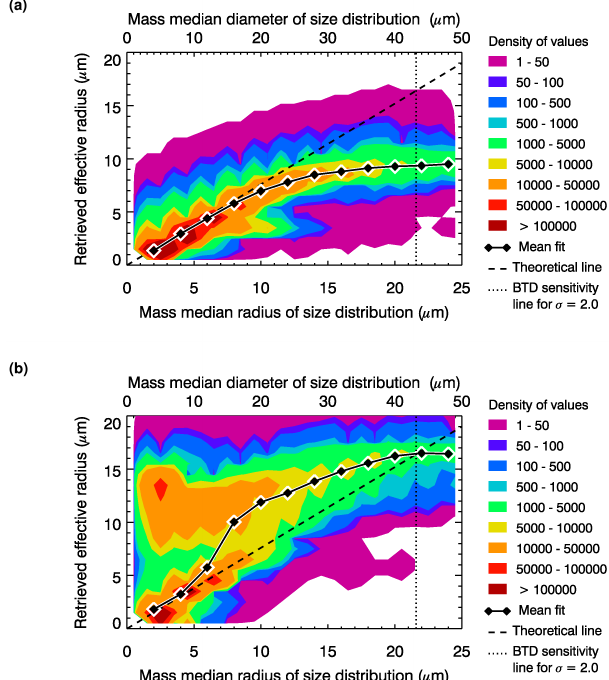
Figure 10. Retrieved effective radius for pixels where retrieved values give good fit to simulated images (i.e. total cost <12) and mass loading > 0.2gm − 2 against mass median radius of a lognor- mal PSD with geometric standard deviation of 2.0. The coloured contours represent the density of values from the pixels in the 12 simulated satellite images. The black diamonds are the mean re- trieved effective radius for the given mass median radius of the PSD. The vertical dotted line shows the limit of sensitivity for the BTD method; ash-containing pixels in coarser PSDs were identified by additional tests. (a) The mean retrieved effective radius tracks the theoretical effective radius up to around 10µm. PSDs that are coarser than this still return a mean effective radius of around 9µm. There is a population of retrievals clustered around the a priori ef- fective radius of 3.5µm. (b) As above, but with a priori effective radius of 15µm. This value is much higher than is used in practice, but the plot illustrates the sensitivity of the retrieval to the a priori estimate.